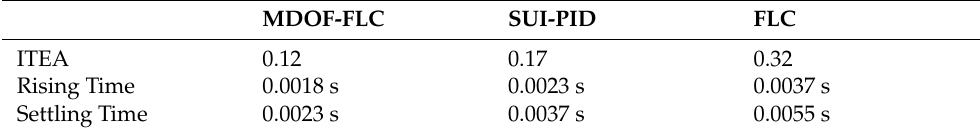
Figure 16. The output of different controllers under various irradiance levels. Table 6. Comparative performance analysis associated with different